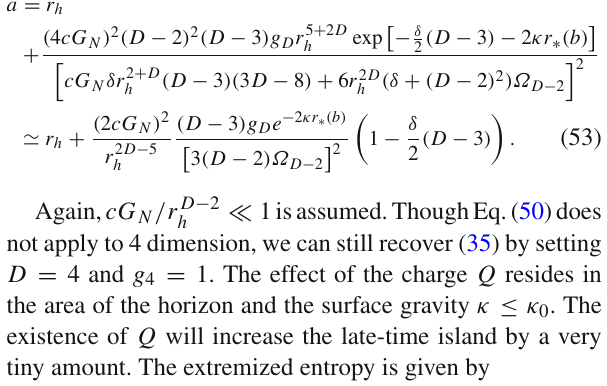
Fig. 2 An illustration of the time evolution of entropy of Hawking radiation for Kaluza–Klein black holes. The blue line represents the entropy without island while the horizontal green line stands for the late-time generalized entropy with an island. The solid part of these curves are understood as the entanglement entropy for Hawking radia- tion according to QES prescription. A phase transition happens at the Page time t